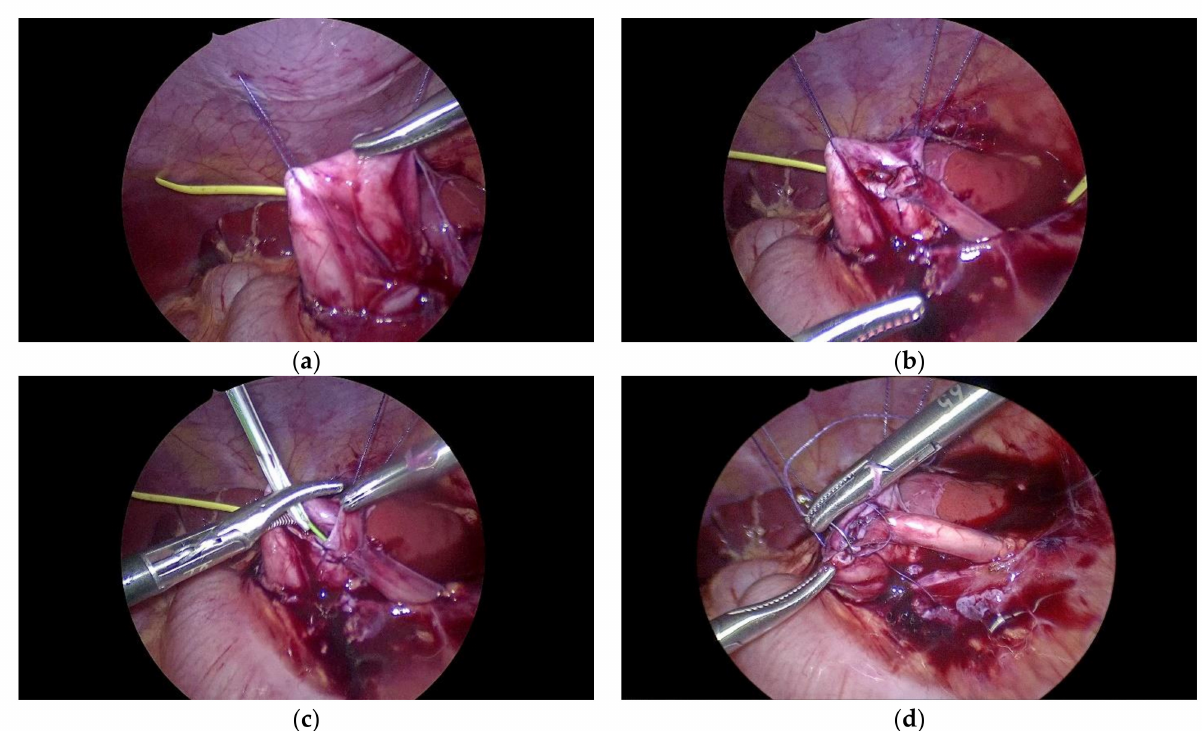
Figure 5. ( a ) Exposition of the ureteropelvic junction obstruction with stay sutures. ( b ) The posterior wall of the anastomosis between the pyelon and left ureter is finished. ( c ) Insertion of the pigtail catheter after the posterior wall of the anastomosis had been completed. ( d ) The anterior wall of the anastomosis is finished with eight single stiches of Vicryl